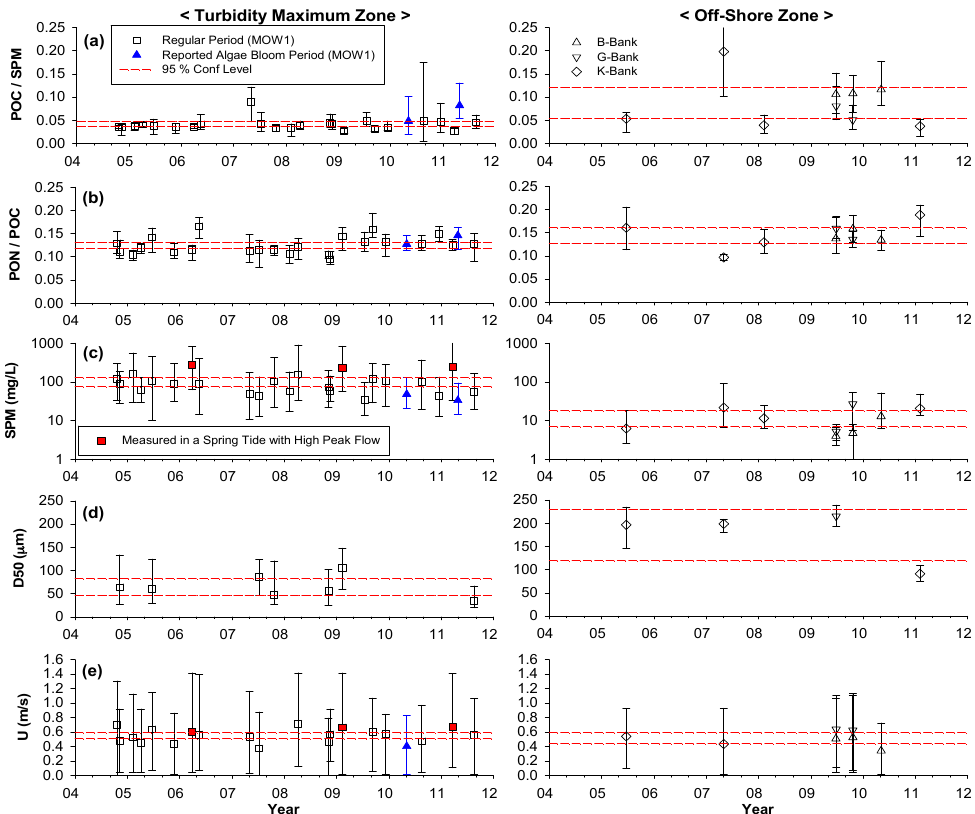
Figure 2. Spatial and seasonal variation of experimental indices in the measurement sites, during the entire measurement period, from 2004 to 2011. The left and right panels illustrate the data obtained from the turbidity maximum zone (TMZ) and the offshore zone (OSZ), respectively. ( a ) POC content in the SPM; ( b ) POC/PON ratio; ( c ) SPM concentration; ( d ) D50: median of the volumetric particle/aggregate size distribution; ( e ) U: flow velocity; MOW1: measurement site in the TMZ; B-Bank, G-Bank, and K-Bank: measurement sites in the OSZ.